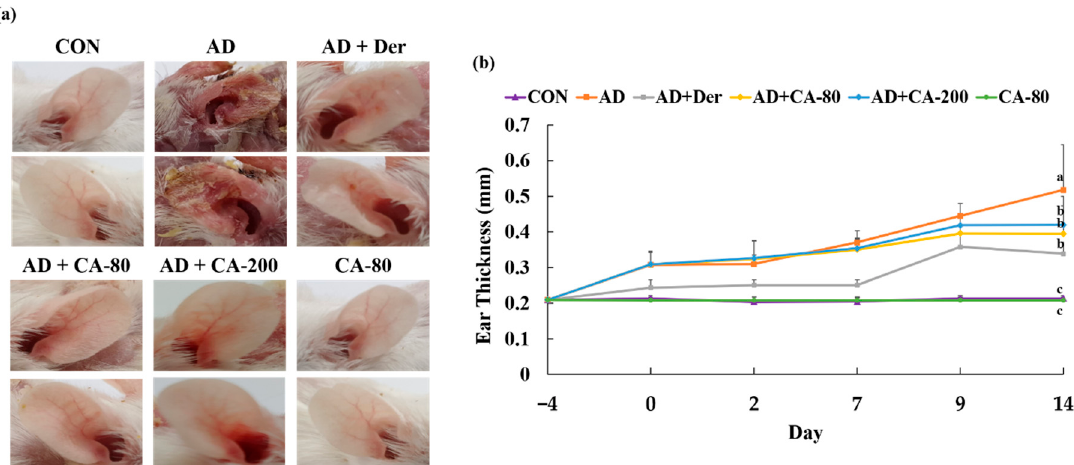
Figure 5. Histopathological analysis to assess the e ff ect of CA on mice ear thickness. ( a ) Photographs of mice ears from each group on day 14; ( b ) The ear thickness was measured 24 h after DNCB application with a dial thickness gauge. Values represent the mean ± SD. Values with di ff erent letters were significantly di ff erent according to Duncan’s multiple range test ( p < 0.05).